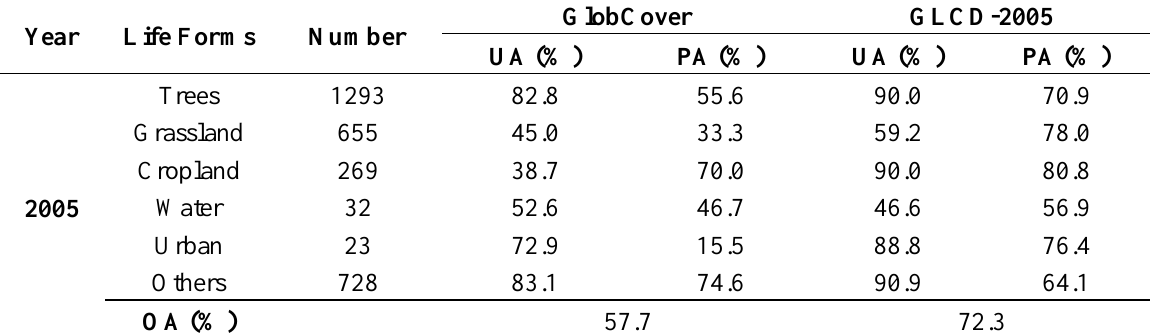
Table 4. Summary of error matrixes for GlobCover (GLOBCOVER land cover product), and a national land cover map GLCD-2005 (Geodata Land Cover Dataset for year 2005) in